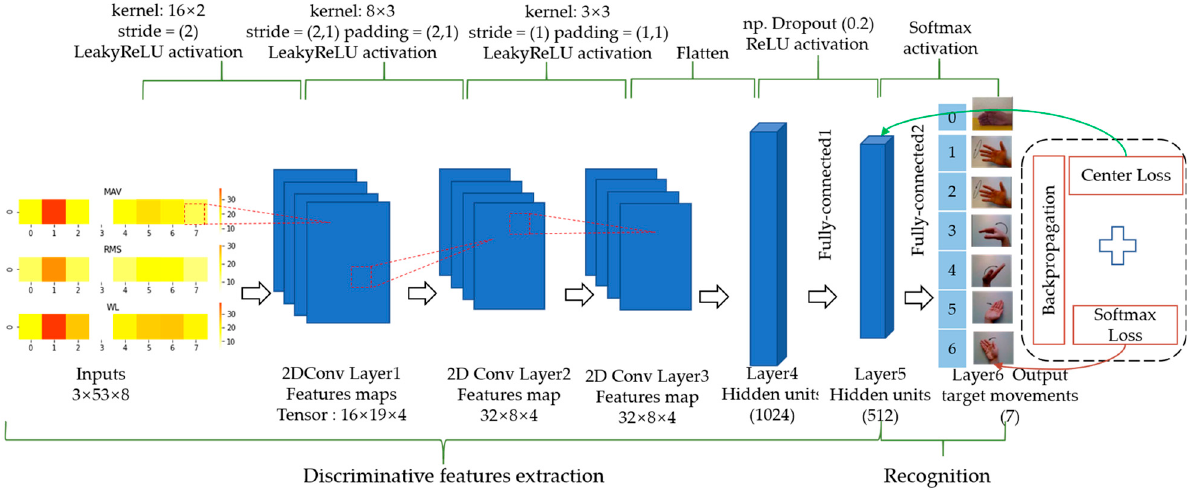
Figure 4. The architecture of the CNN model developed in this paper.